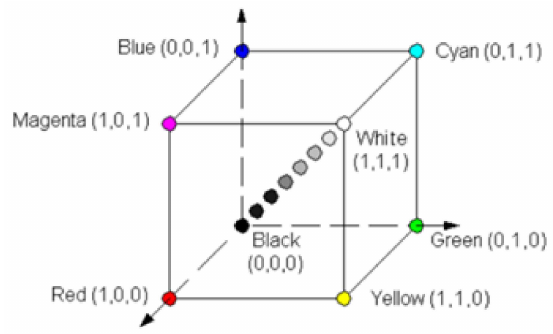
Figure 31. Three-dimensional RGB color space.